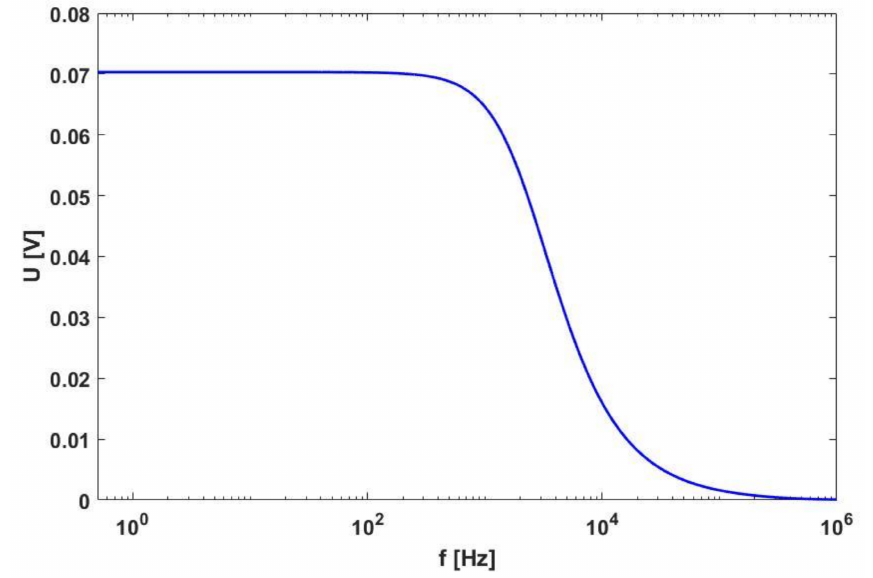
Figure 3. Frequency spectrum of the voltage surge